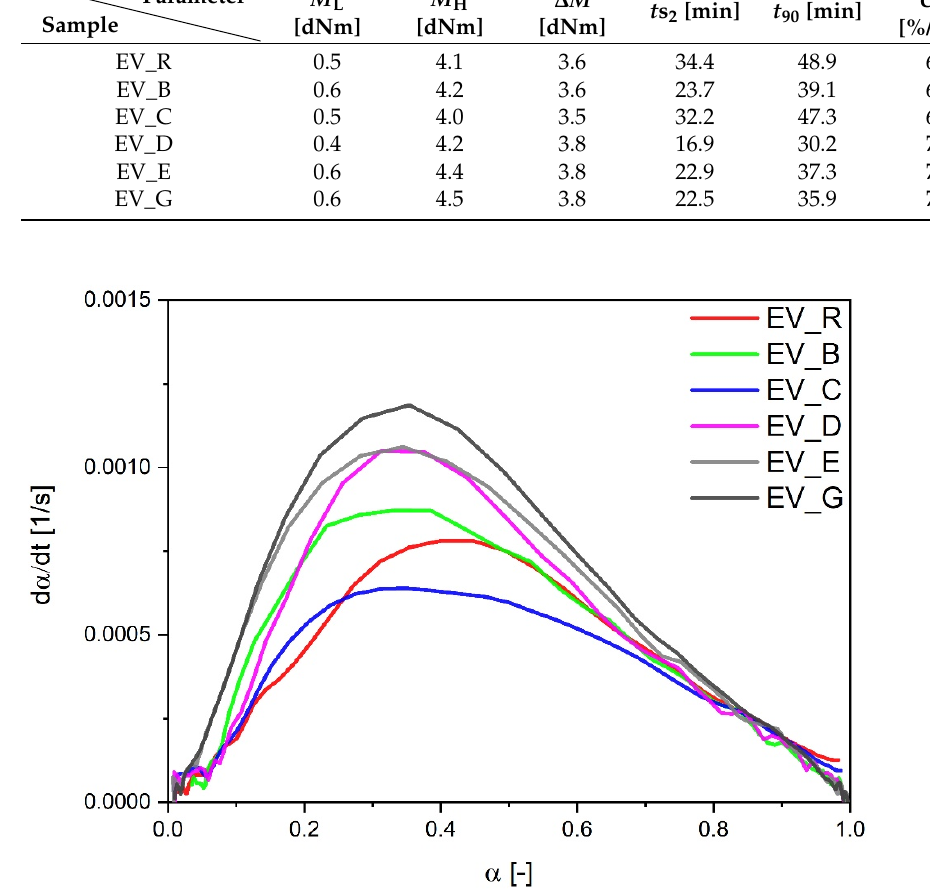
Figure 4. Vulcanization speed as a function of the vulcanization degree for rubber compounds